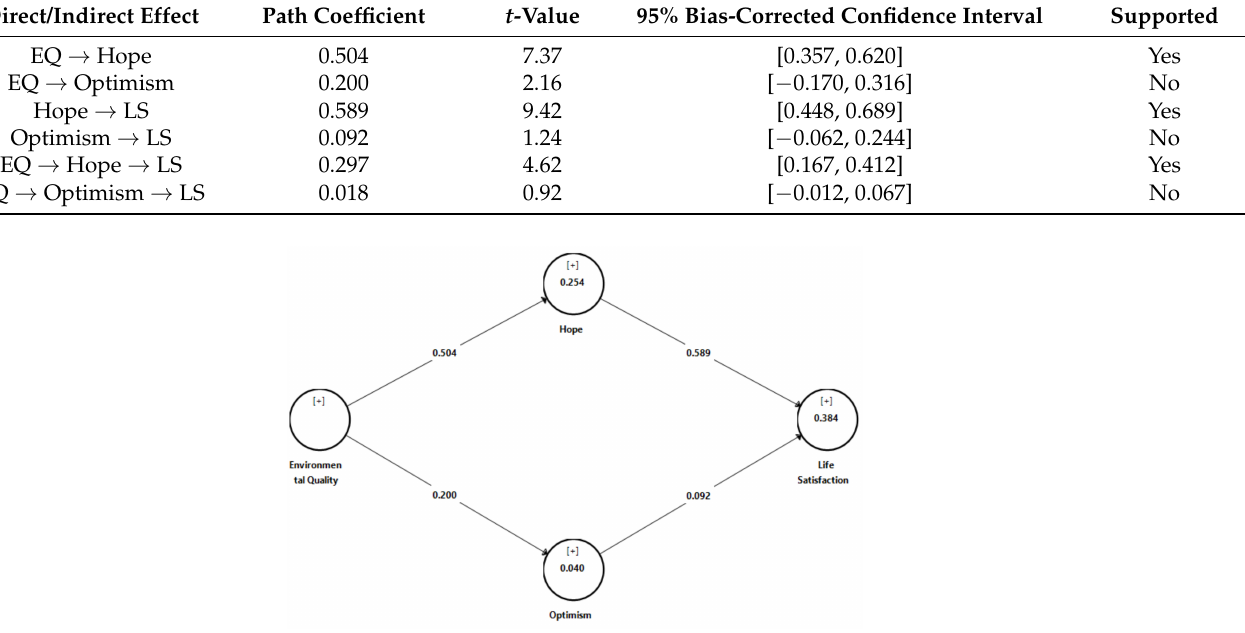
Figure 1. Results of assessment of structural